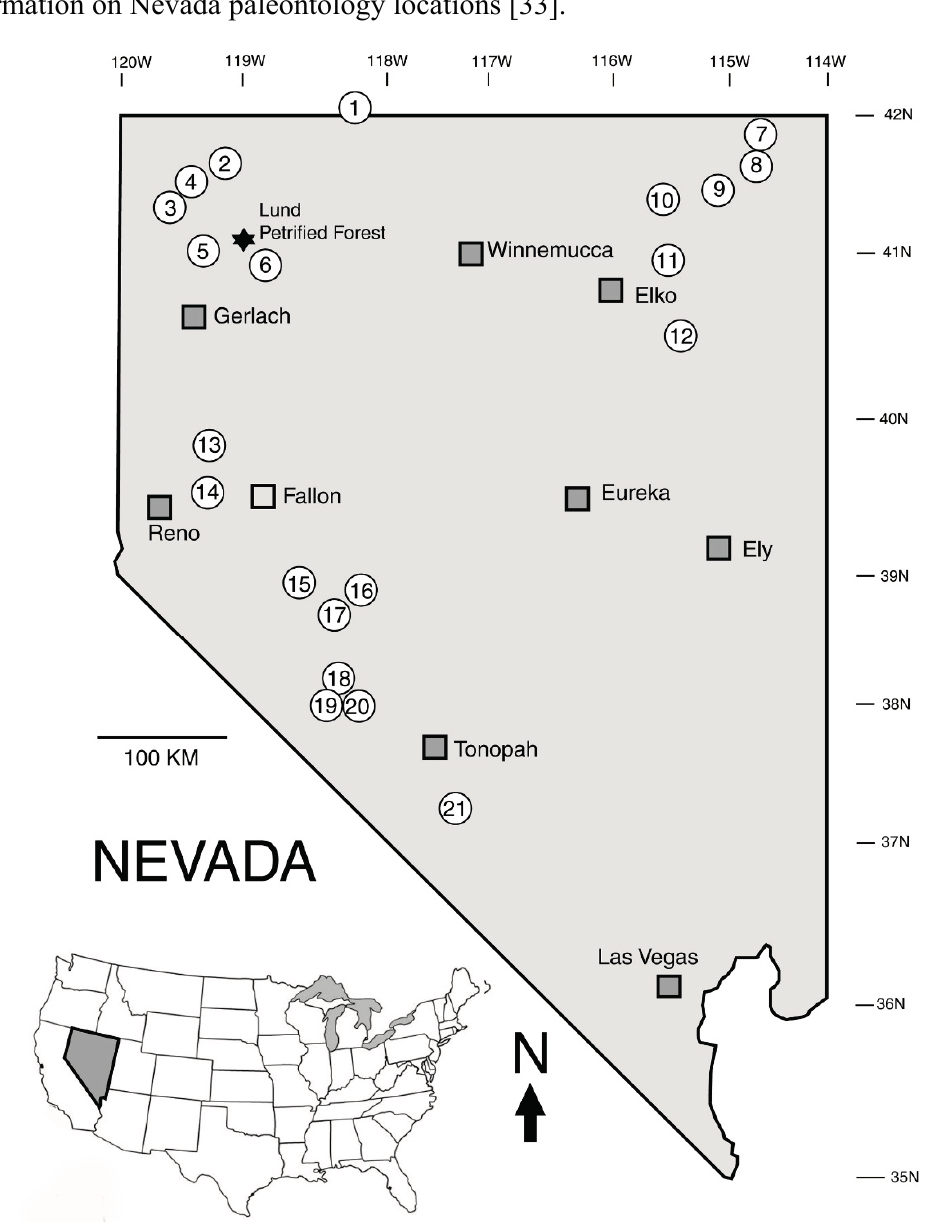
Figure 3. Localities for petrified wood specimens used in this study. See Table 1 for